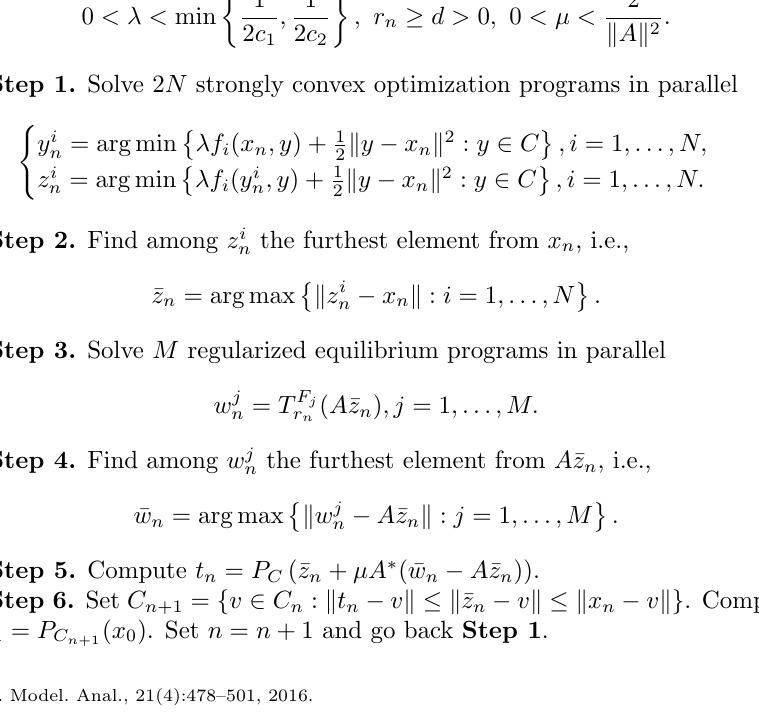
Algorithm 2. (Parallel hybrid extragradient-proximal method for